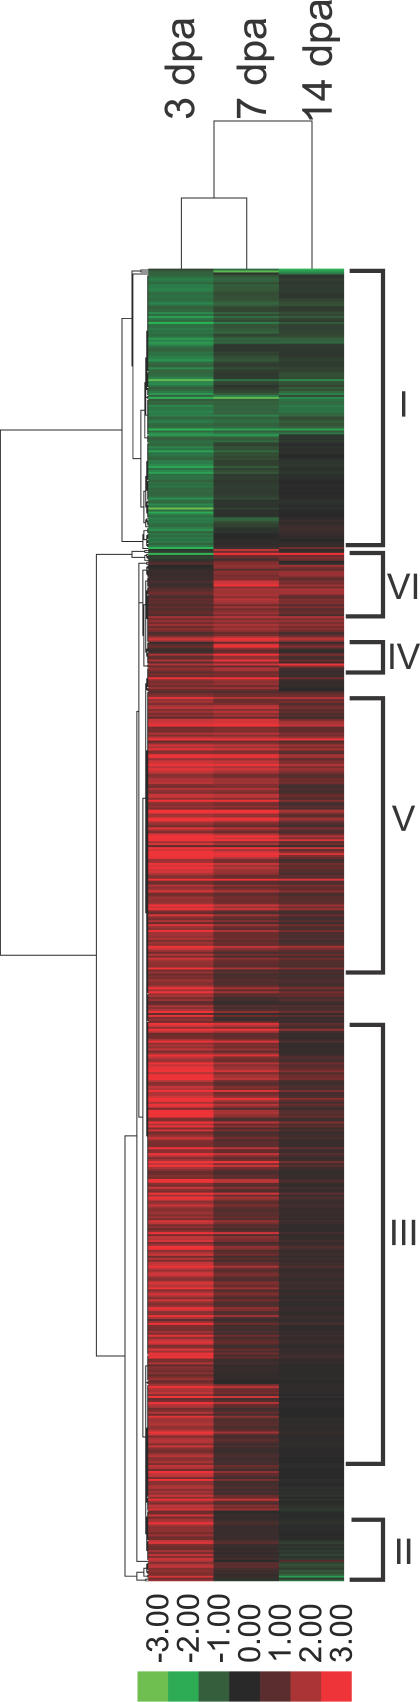
Gene Expression Profiling of Zebrafish Heart RegenerationA total of 662 genes are differentially expressed during zebrafish heart regeneration. These genes were clustered into groups using the hierarchical method based on the similarity of their expression patterns during heart regeneration at 3, 7, and 14 dpa. The color chart indicating fold change of expression uses a base 2-logarithm scale. Red and green represent increased and decreased expression, respectively. Pairwise comparisons revealed that regenerating hearts at 3 dpa had the most differentially expressed genes and that 3 dpa and 7 dpa regenerating hearts shared a high percentage of genes that had increased expression during regeneration.